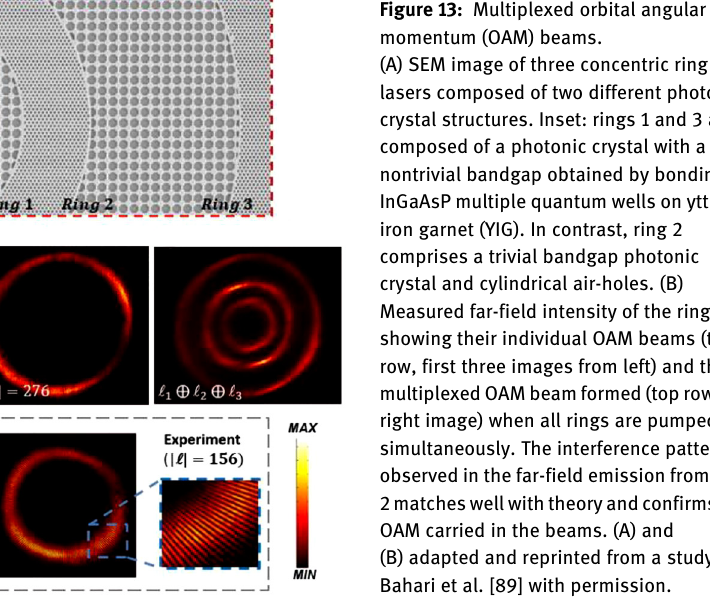
Figure 13: Multiplexed orbital angular momentum (OAM)